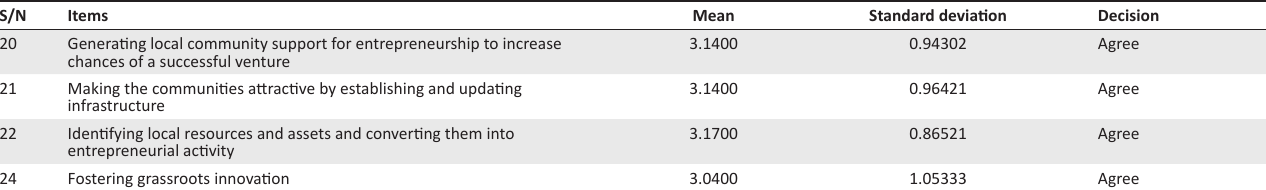
TABLE 5: Distribution on solution to challenges of rural entrepreneurs. S/N